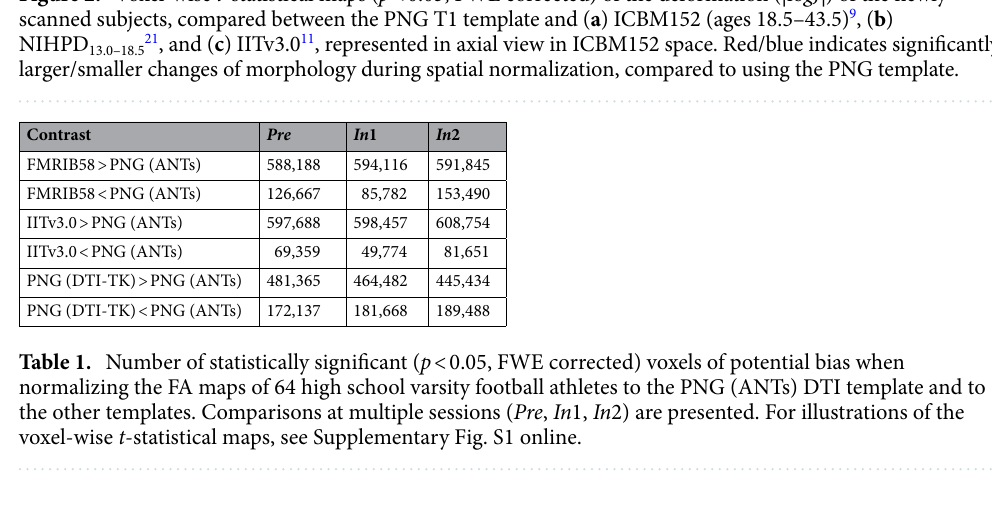
Contrast Pre In